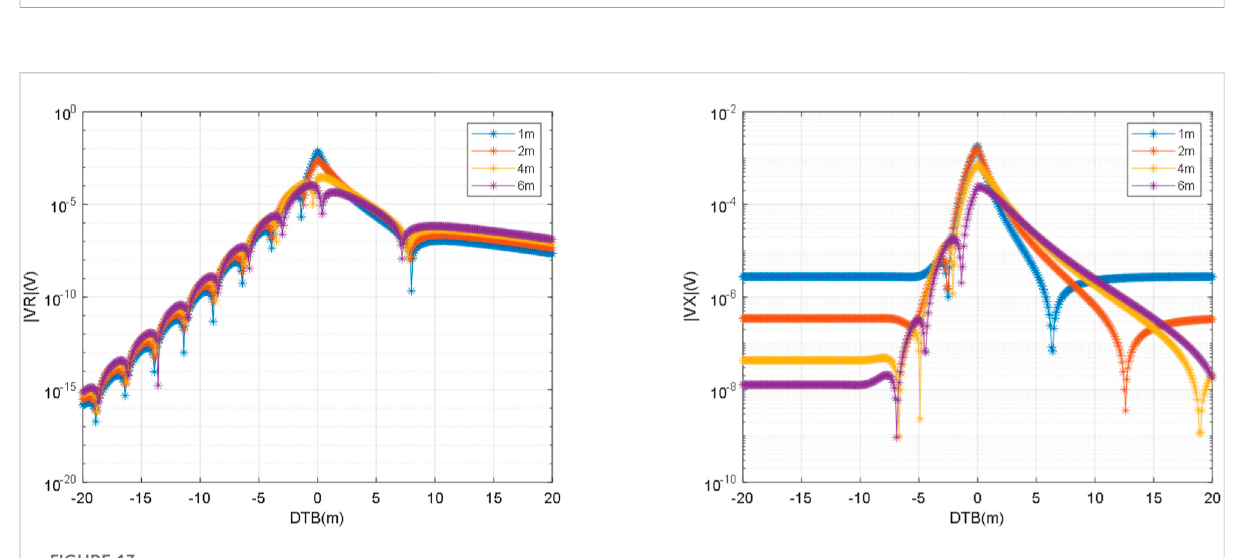
FIGURE 13 Response of the orthogonal receiver at different source